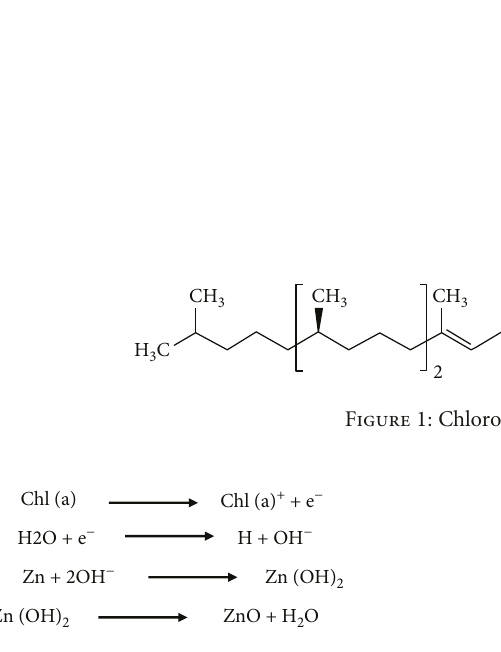
Scheme 2: A mechanism proposed for the catalytic preparation of ZnO